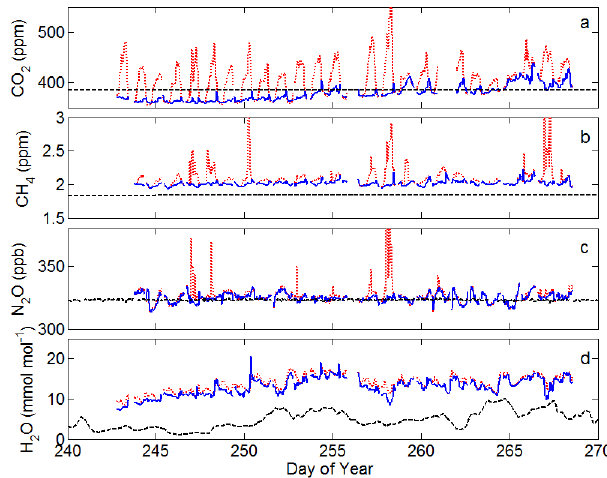
Figure 4. Hourly averages of CO 2 (a) , CH 4 (b) , N 2 O (c) , and H 2 O (d) mixing ratios during the observation period from DOY 243 to DOY 269, 2009. Blue solid line – mixing ratio on 200m. Red dotted line – mixing ratio on 3m. Black dashed line – mixing ratio at Niwot Ridge